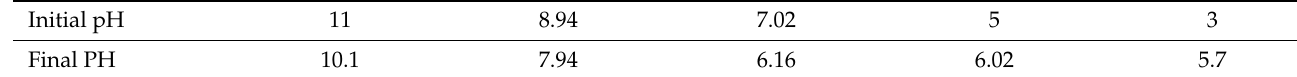
Table 2. Drift method experimental results.